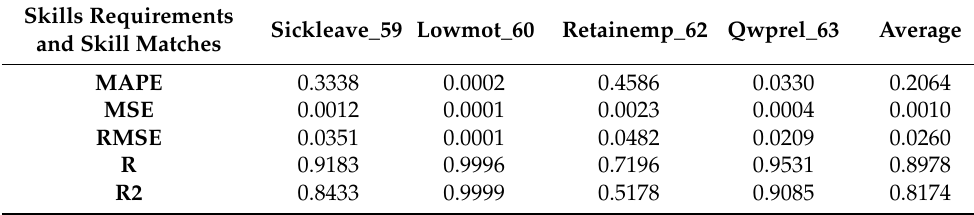
Table 9. Testing results for the effect of skills requirements and skill matches on employee